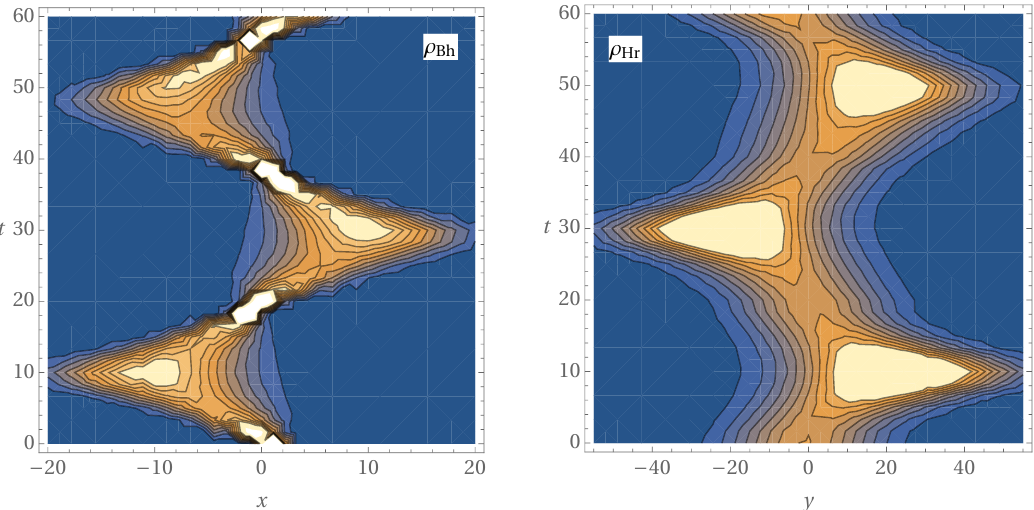
Figure 2. Diagonal reduced density matrix elements ρ Bh and ρ Hr (defined in Equations (48) and (49)) evolution over time, with m Pl = ¯ h = ω x = x 0 = 1; p 0 = − 1. The back reaction coupling value is µ ≈ 1.01, where ω y = ω x × 10 5/2 and m y = m Pl × 10 − 5 . Light areas, in the density plots, correspond to higher values of the density